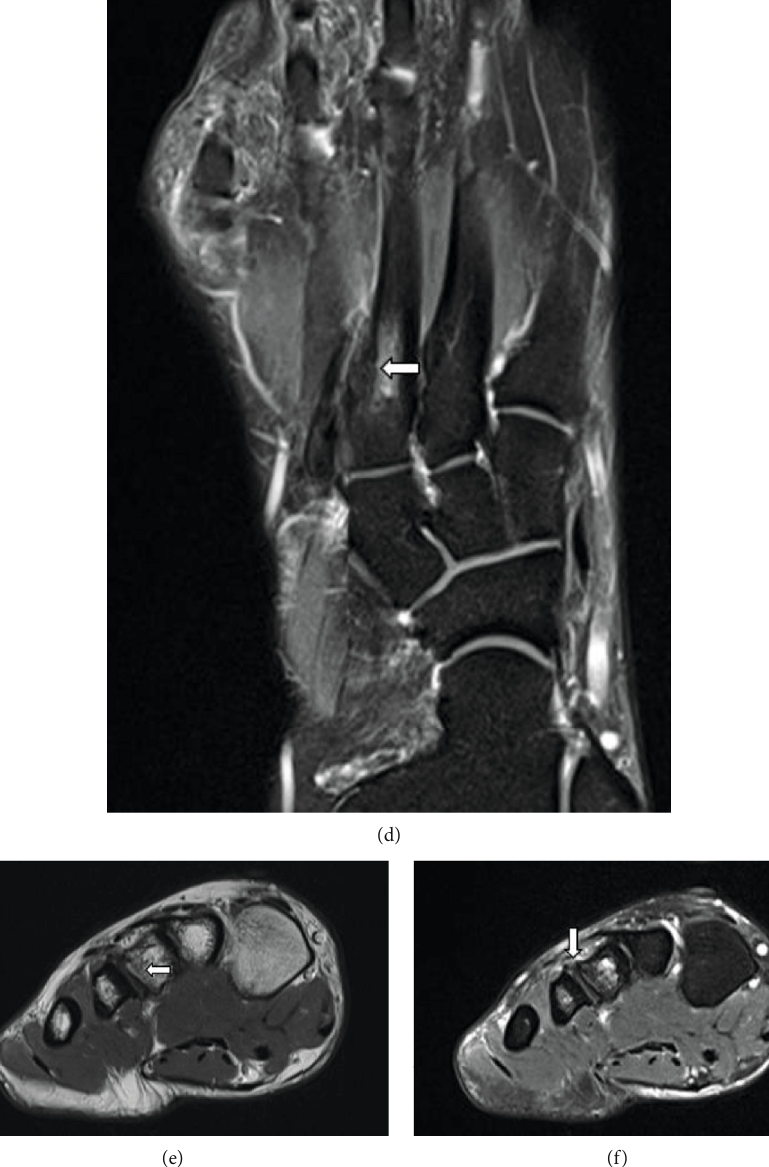
Figure 2: 29-year-old female with dorsolateral foot pain. Ultrasound in axial view of the proximal metatarsals (a) shows abnormal bony overgrowth in the dorsal border of the third and fourth intermetatarsal space. This is associated with adventitial bursal formation, soft tissue oedema, and increased vascularity. AP (b) and oblique (c) radiographs show abnormal articulation at the base of the third and fourth metatarsals with sclerosis at the site of the approximation. Coronal PDFS (d) with nonosseous coalition at the third and fourth intermetatarsal spaces. Associated periostitis and intramedullary oedema signal. Axial PD (e) and PDFS (f). Marrow oedema signal. Osteitis and periostitis. Abnormal articulation at this level with surrounding bone